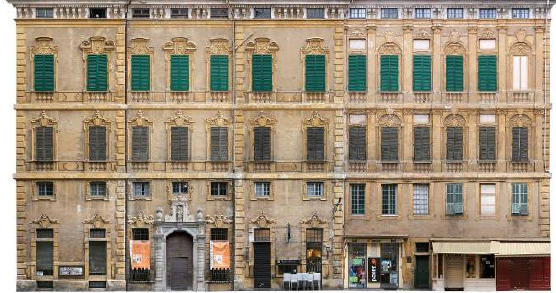
Figure 2. Main front of the Palazzo Borea d’Olmo, Sanremo (IM), Via Matteotti.